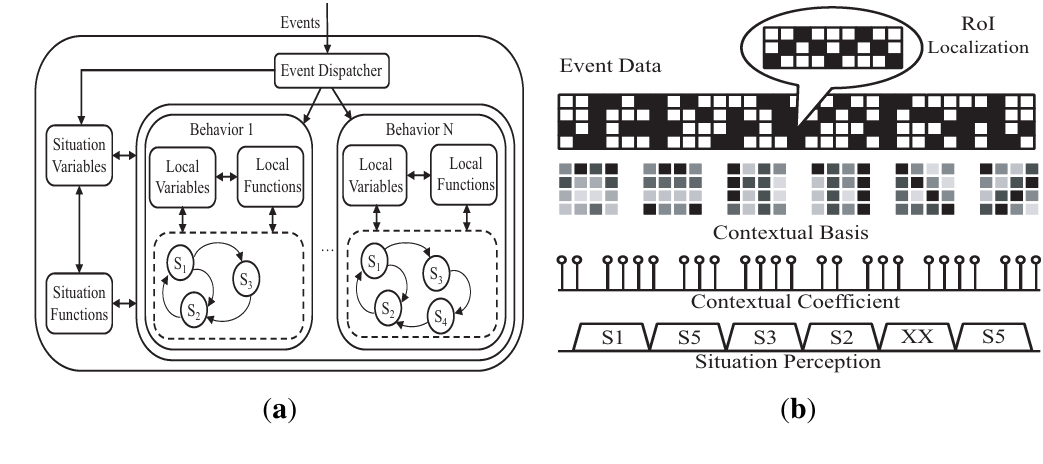
Figure 2. Illustration of ( a ) agent architecture; ( b ) situation perception from event